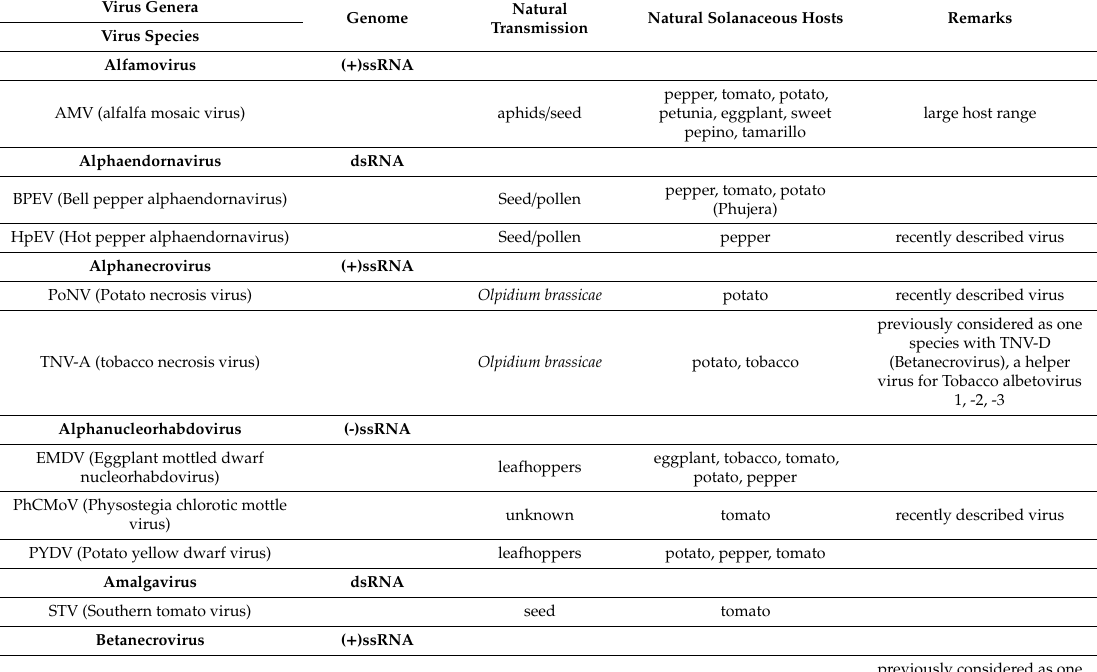
Table 2. List of selected viruses naturally infecting plants of the Solanaceae family